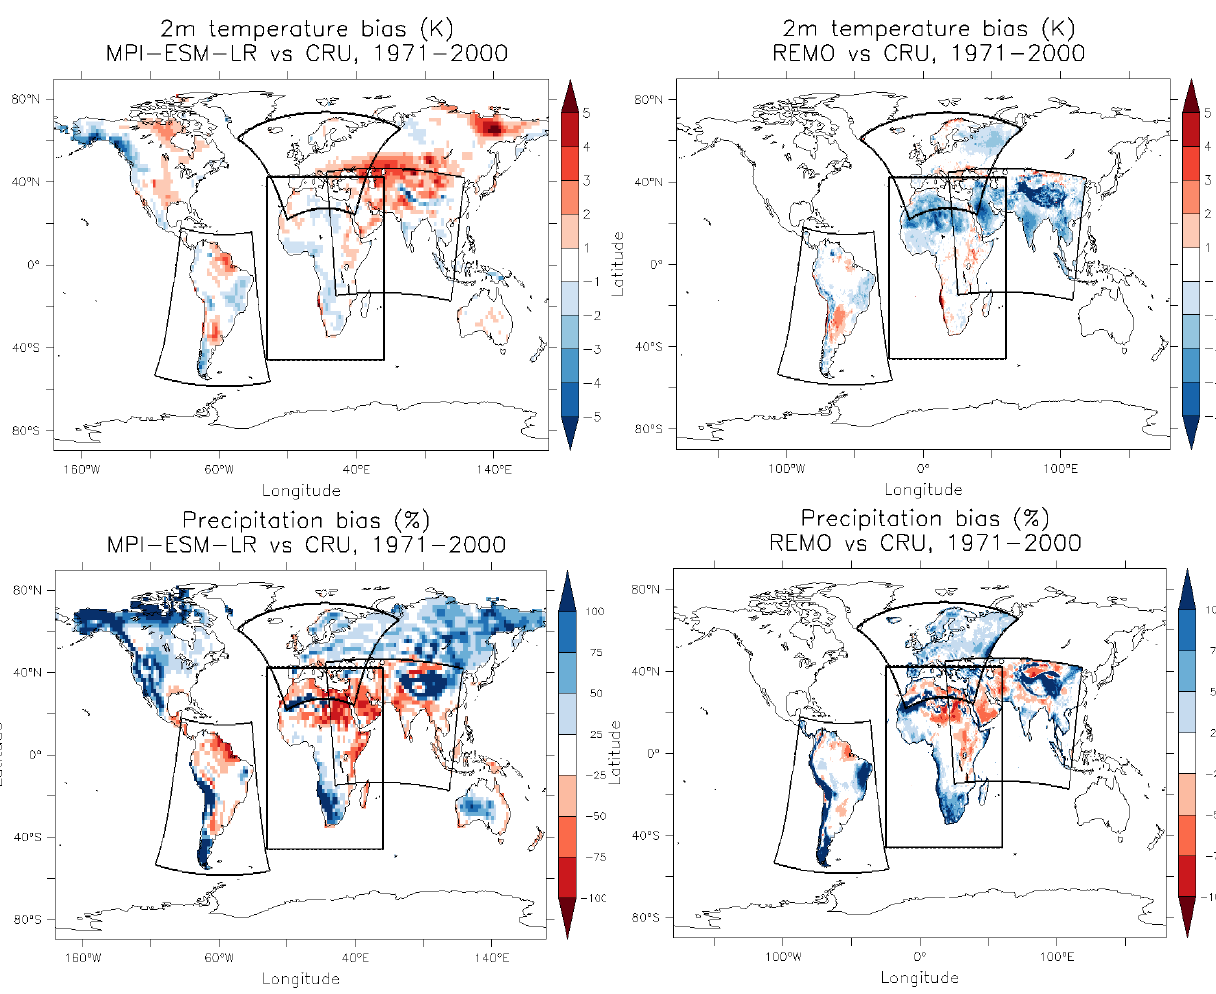
Figure 2. Historical time period compared with CRU, annual mean 2m-temperature and annual precipitation sums. The temperature difference is plotted in K in the upper panels for the historical time period as simulated by the Earth system model MPI-ESM (LR) (left panel) and REMO (right panel). Precipitation differences are plotted in mm/day in the lower panels as simulated by the Earth system model MPI-ESM (LR) (left panel) and REMO (right panel) compared to observational data of